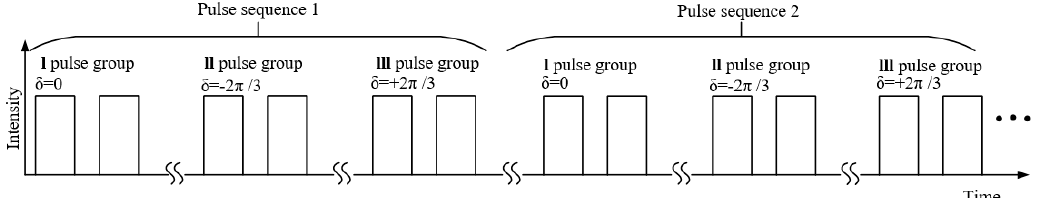
Figure 12. Pulse pair sequences with a phase shift of 0, +2 π /3, − 2 π /3 respectively in the second pulse.